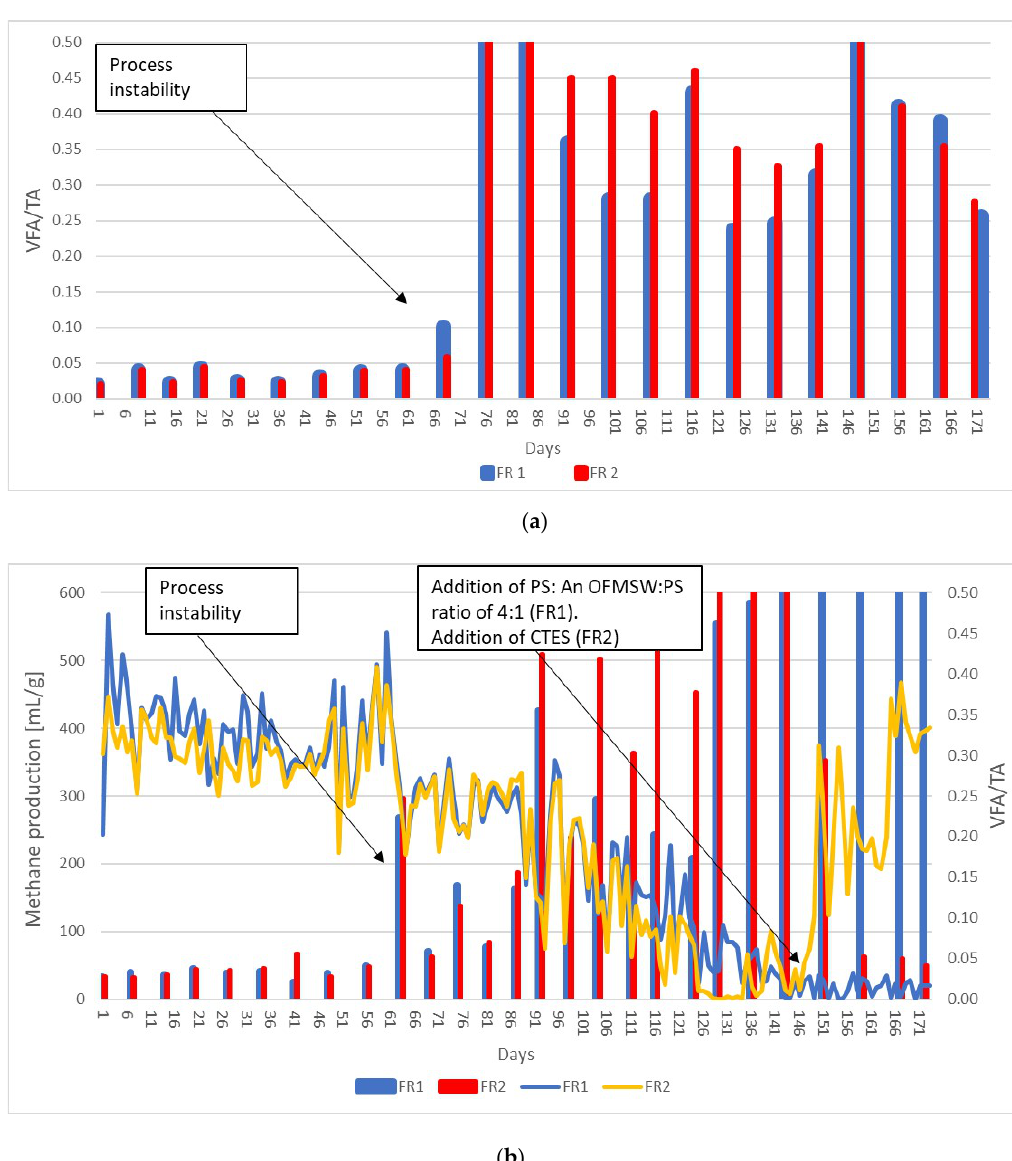
Figure 4. The ratio between VFA and TA in digesters fed with OFMSW as mono-substrate in two similar trials performed at OLR of 1.0 g/L/d ( a ) the first experimental trial; ( b ) repeated experimental trial where the specific methane production is also presented, and the starting point for the addition of PS to an OFMSW:PS ratio of 4:1 (FR1) or addition of Commercial Trace Element Solutions (CTES) (FR2) is shown. The staples represent the obtained VFA/TA ratios (right y-axis), while the blue (FR1) and yellow (FR2) lines show the methane production (left y-axis).